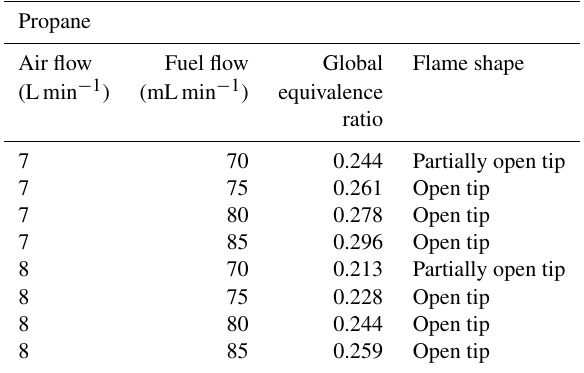
Table 1. Combustion parameters and flame shapes selected for propane.